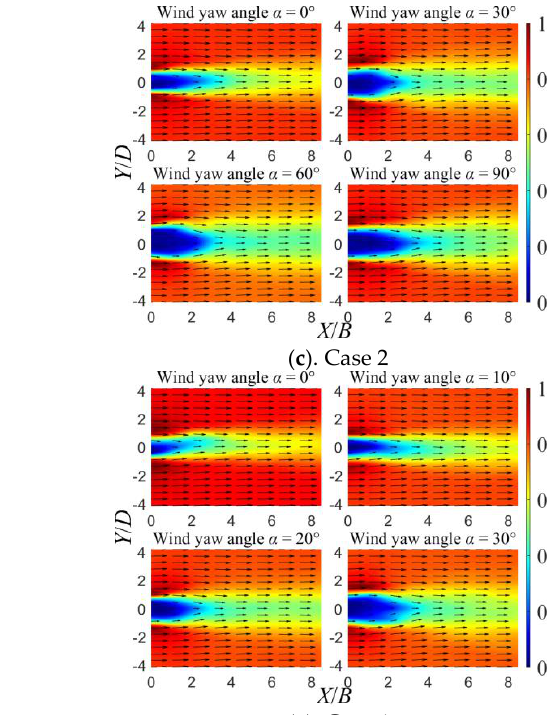
Figure 4. Dimensionless mean speed ( U / U 0 ) distribution of tower wake.